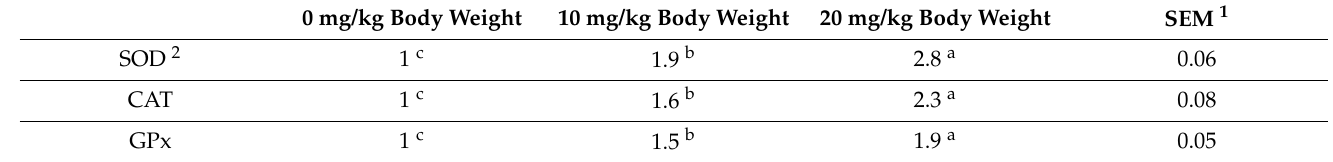
Table 4. The expression analyses of antioxidant-related genes in the liver of